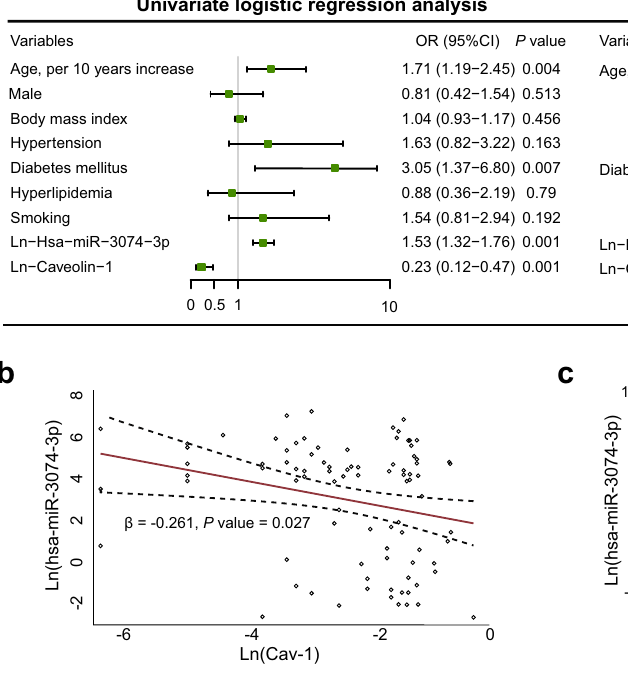
while OR to the left of the midline indicate lower odds of leukoaraiosis. n =66 in control and n =88 in case. b Linear Regression assessing the association between hsa-miR-3074-3pand Cav-1 in patientswith leukoaraiosis. The solidline represents the regression line and dashed lines represent the 95% CI. n =66 in control and n =88 in case. c , d Real-time PCR showing the serum hsa-miR-3074-3p and Cav-1 level in patients with mild or severe leukoaraiosis ( n =66 in control and n =88 in case; mean±SD.; unpaired t -test). Dots are all the data points including outliers. Source data are provided as a Source Data fi